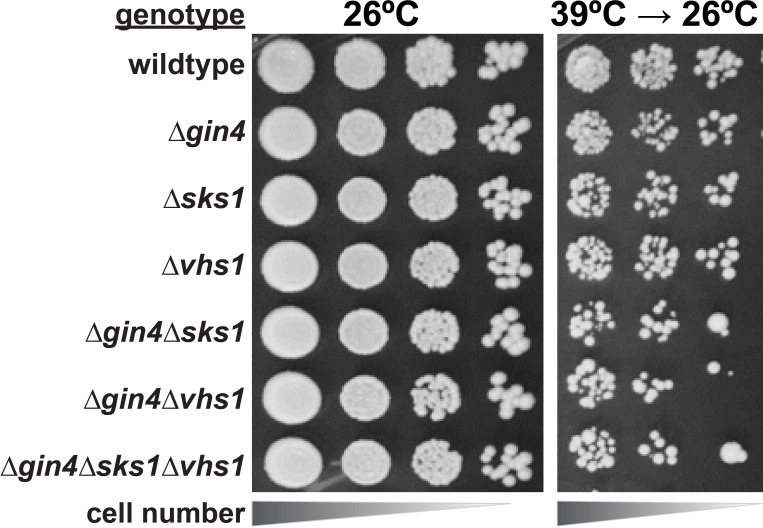
Analysis of cell tolerance to heat stress in yeast kinase deletion cells.Null-mutants derived from SEY6210 yeast strain were serially diluted onto YPD plates and incubated at 26°C or 39°C for 18 hr and shifted to 26°C for growth recovery.